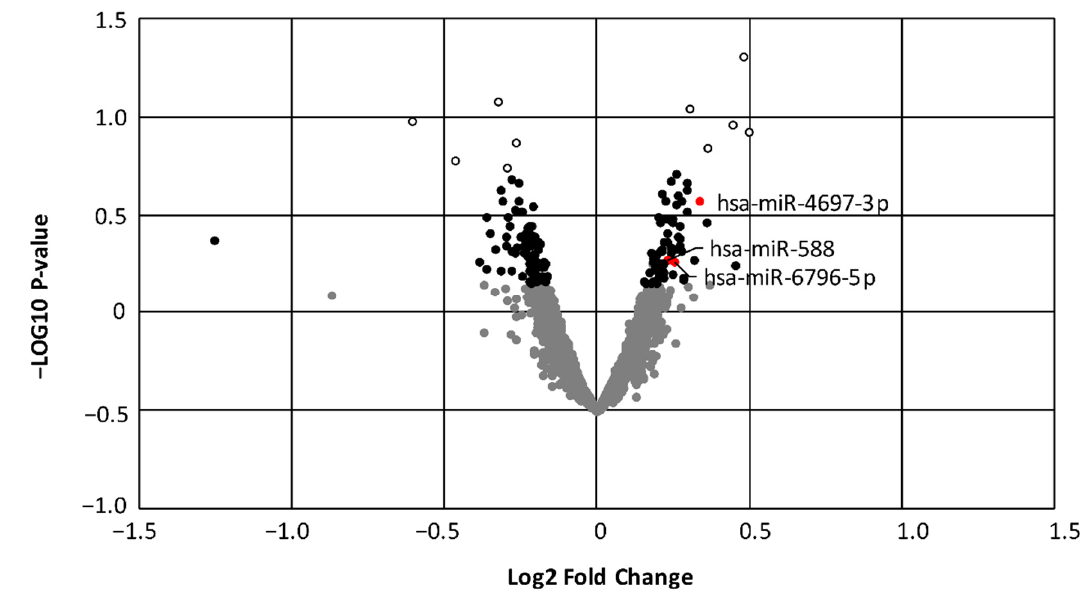
Figure 1. Volcano plot representing differentially expressed miRNA in MHO and MUO groups. Black dots indicate significantly different levels of miRNAs in MUO vs. MHO. Red dots are the 3 miRNAs chosen for validation. Empty dots are the top 5 up- and downregulated miRNAs. Table 2. Top 5 up- and downregulated miRNAs in MUO vs. MHO subjects.